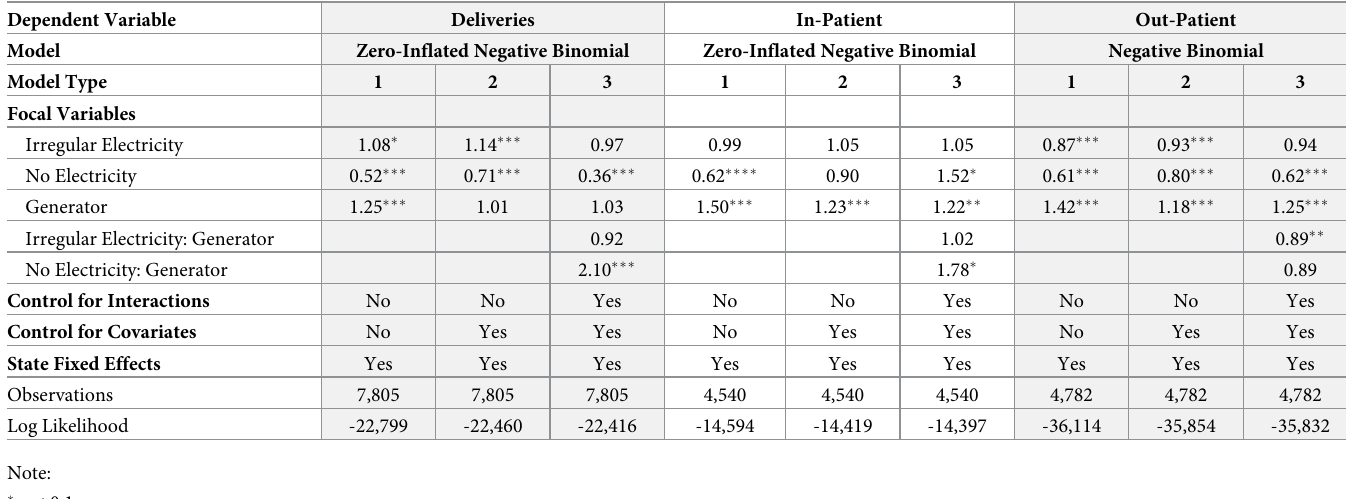
Table 3. Incidence Rate Ratios (IRR) (exponentiated log-odds) for the focal variables in the regression models for three outcome variables of interest.